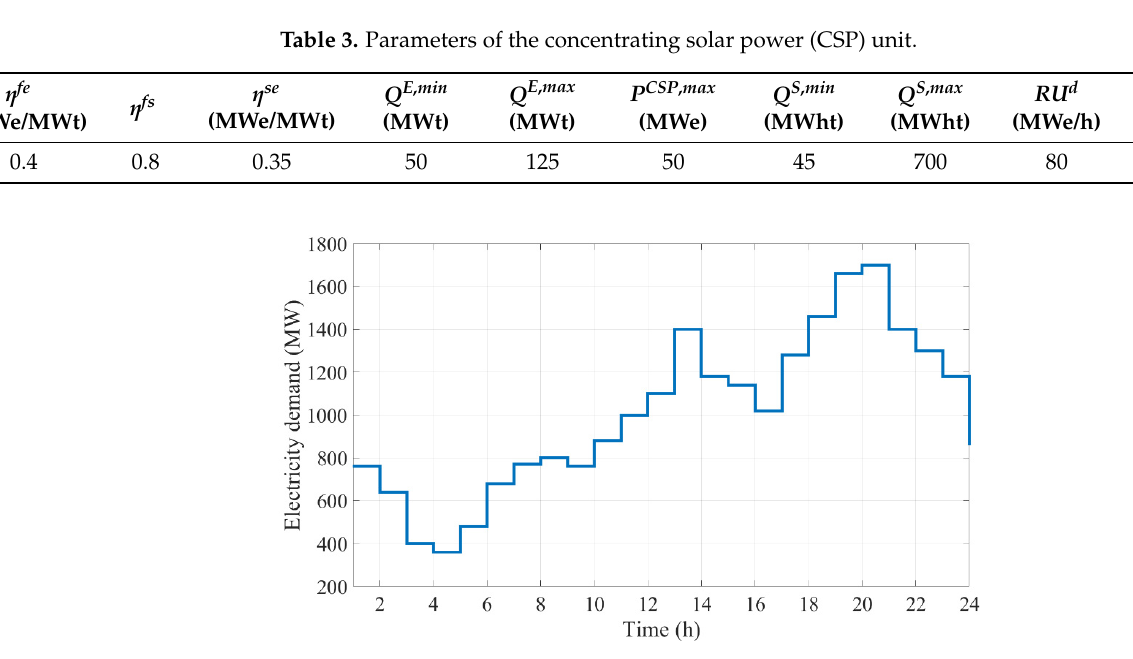
Figure 5. Estimated load profile.